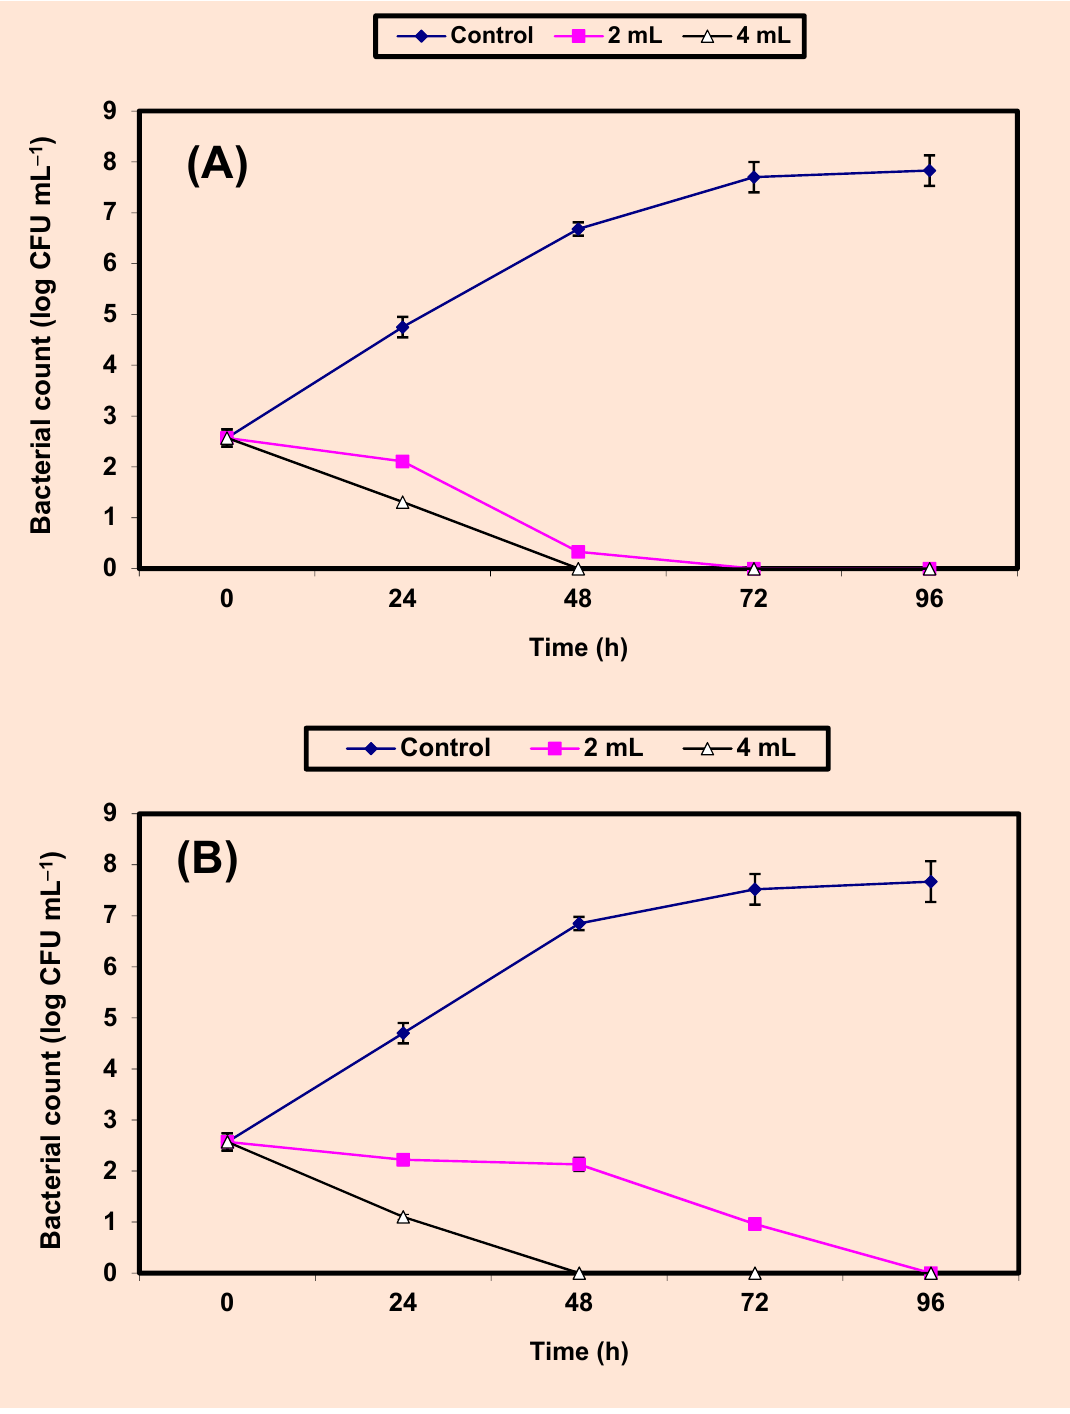
Figure 6. Inhibition of both S. aureus ( A ) and Sal. typhimurium ( B ) in strawberry juice. Symbols ♦ , ■ , ∆ , refer to control untreated samples, juice samples treated with 2%, 4% KB. The inhibition of both S. aureus and Sal. typhimurium in tomato juice by KB (2% and 4%) was studied. Results are given in Figure 7a,b. The untreated control cells increased by